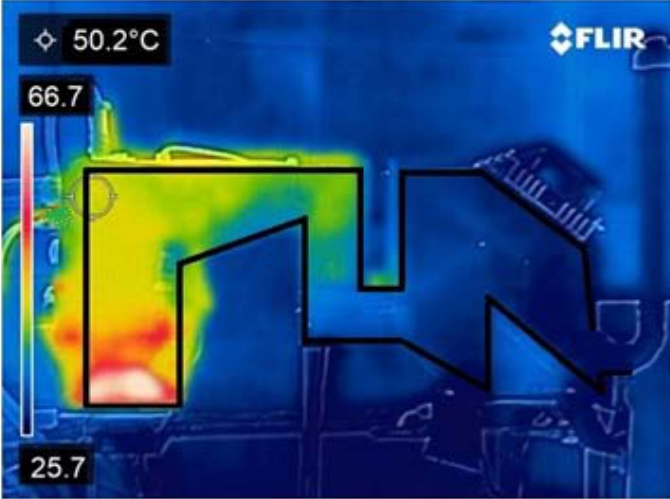
Figure 4. Thermographic profile of the bench-scale ultrasonic prototype for boiler feed water treatment. After arrangement in the form of a table, the results of the Principal Component Analysis (PCA) were standardized by Equation (10) and listed in Table 2. Table 2. Summary of standardized results of Principal Component Analysis applied to experiments carried out on the bench-scale prototype for boiler water ultrasound treatment.